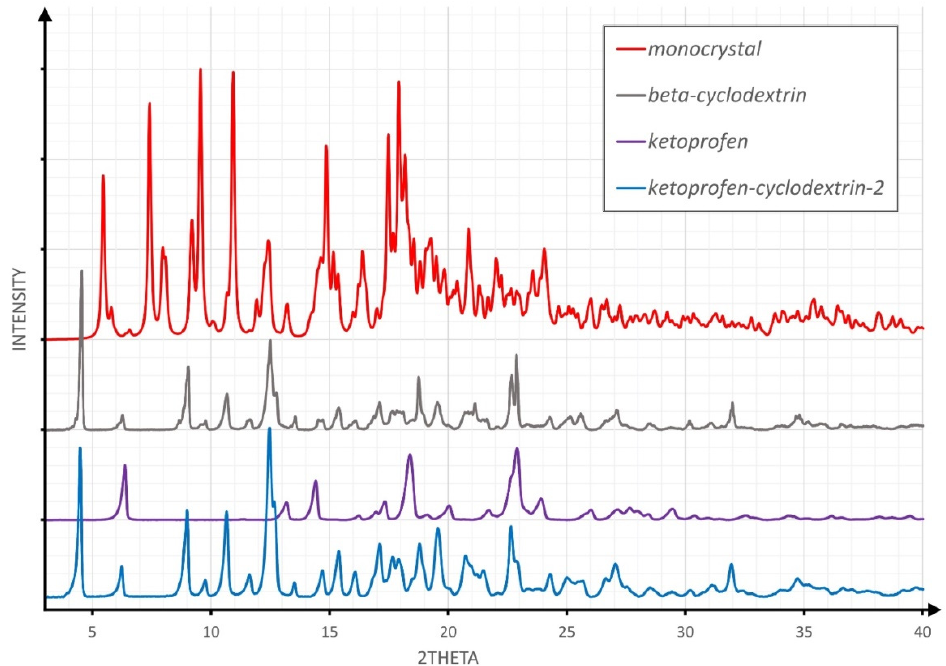
Figure 3. The comparison of XRPD patterns for the product of the evaporation experiment.